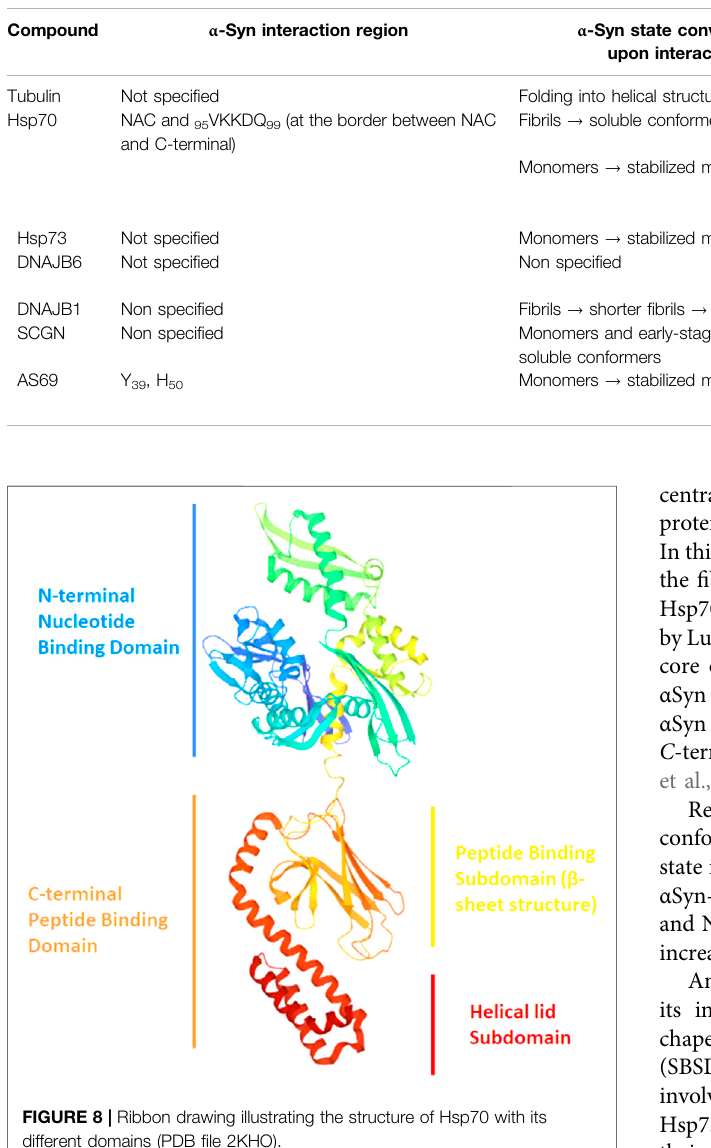
Frontiers in Chemistry |